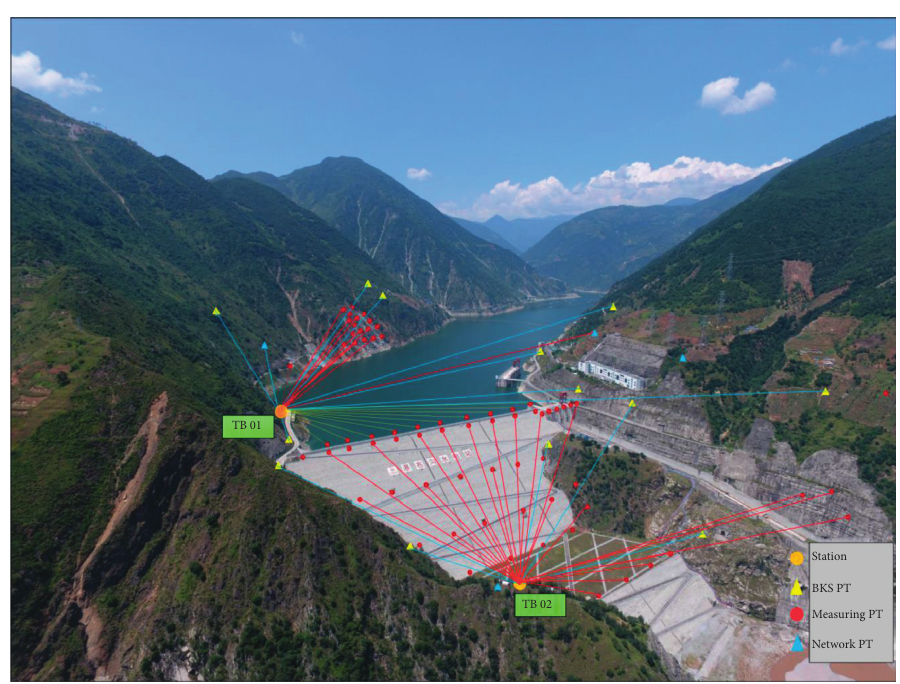
Figure 6: Layout of the deformation measuring points in the Pubugou hydropower